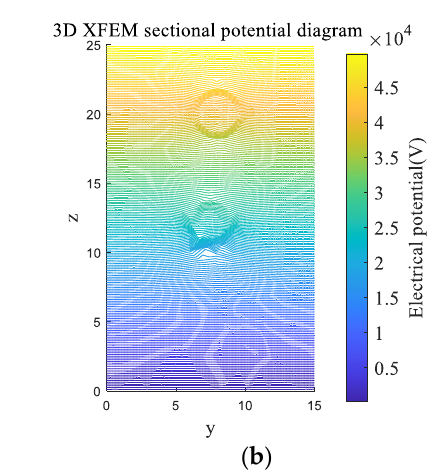
Figure 8. ( a ) 5 bubbles potential diagram at y = 10 mm; ( b ) 5 bubbles potential diagram at x = 7.5 mm. Among the 1159 nodes, the maximum relative error is 7.93% and the average relative error is 1.04%. Ten nodes near the boundary of the sphere are selected to compare